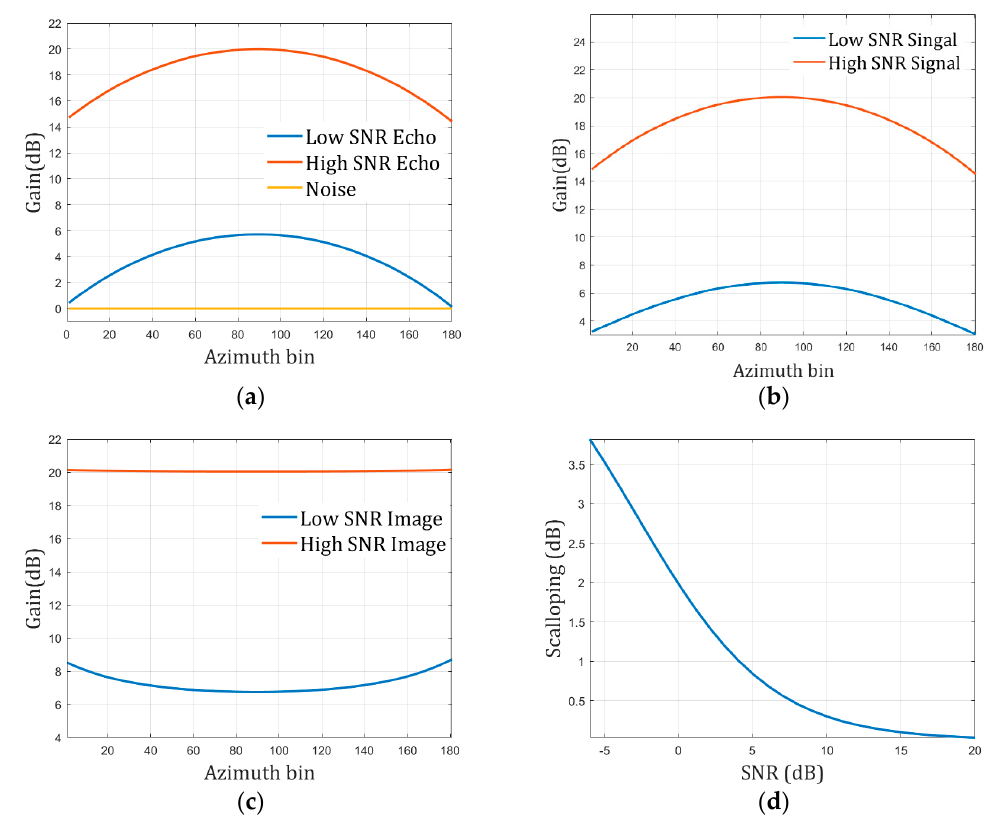
Figure 5. Image radiometric correction schematic diagram of ScanSAR with different signal to noise ratios (SNRs): ( a ) echo of different SNR and noise; ( b ) added noise to echo of different SNR; ( c ) after AAP correction of ( b ); ( d ) relationship between scalloping and SNR.